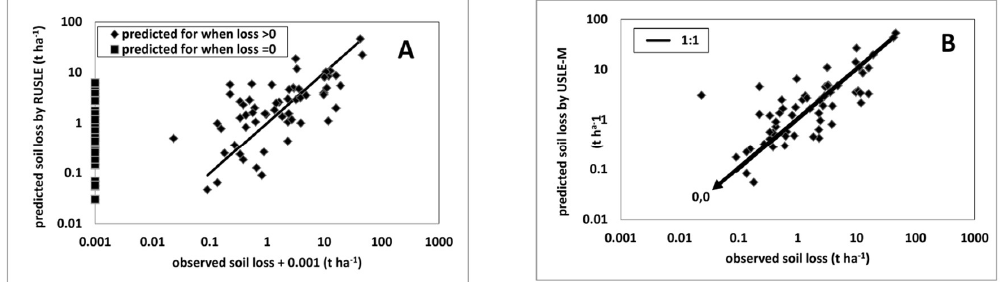
Figure 17. Relationships between observed soil losses on plots 1–2 cropped with corn at Clarinda, IA and soil losses predicted by ( A ) the RUSLE and ( B ) the USLE-M. Note: 0.001 was added to all the observed soil losses from the cropped plot, so that cases where soil loss occurred on bare fallow but not on the cropped plot cold be plotted on when using log-log scales (source: Kinnell [63]).